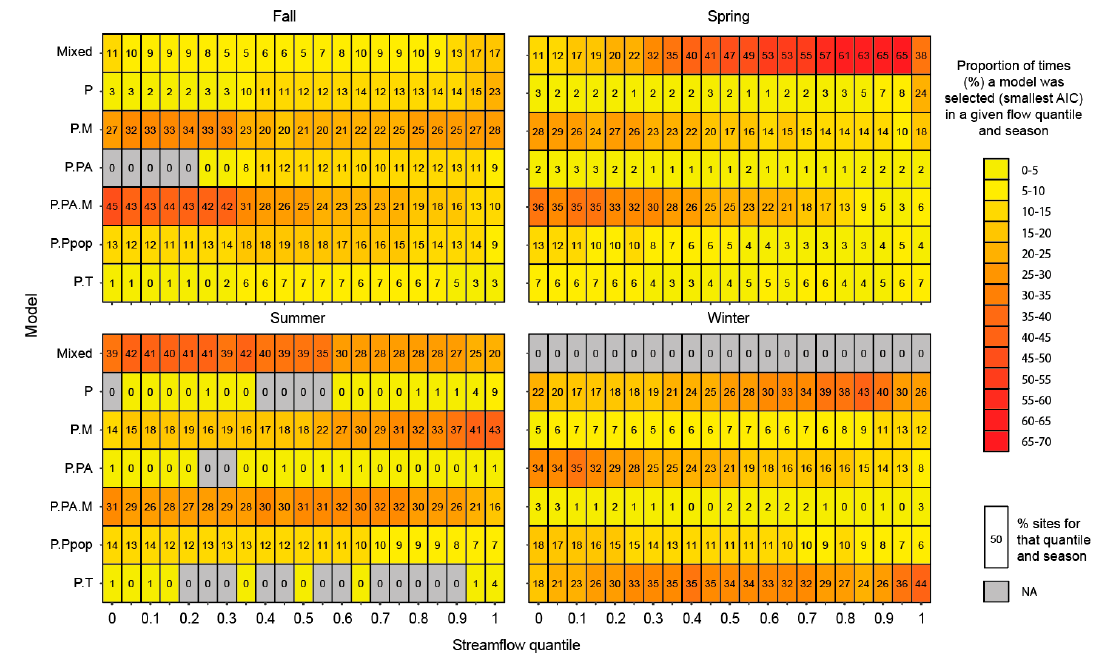
Figure 5. Best-fitting model selection, by flow quantile and season. For every measured quantile, within every season, we compute the number of times (%) that each of the seven models was selected (based on the smallest AIC of the models that were fit for the given site, season and flow quantile). Thus, for example, for the summer low flows ( Q 0 ), P . PA . M was the best-fitting model at 31% of the sites. The four panels indicate the seasons, rows indicate the seven models, and colors indicate the number of times that each model was selected for the given quantile, ranging from less than <5% (yellow) to >45% (dark orange). Grey indicates that the model was not available for selection ( Mixed model in winter) or that no sites were selected. The absolute number of sites where the given model was selected is indicated within each color box.